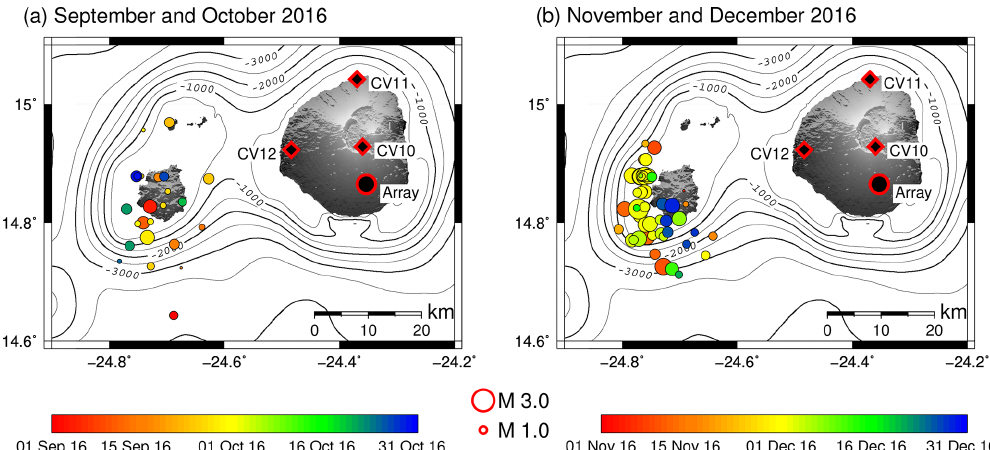
Figure 9. (a) Earthquake locations during September and October 2016. Red/black circle: position of the array, red/black diamond: additional broadband stations on Fogo. (b) The same for November and December 2016. Topographic and bathymetry data are from Ryan et al. (2009).